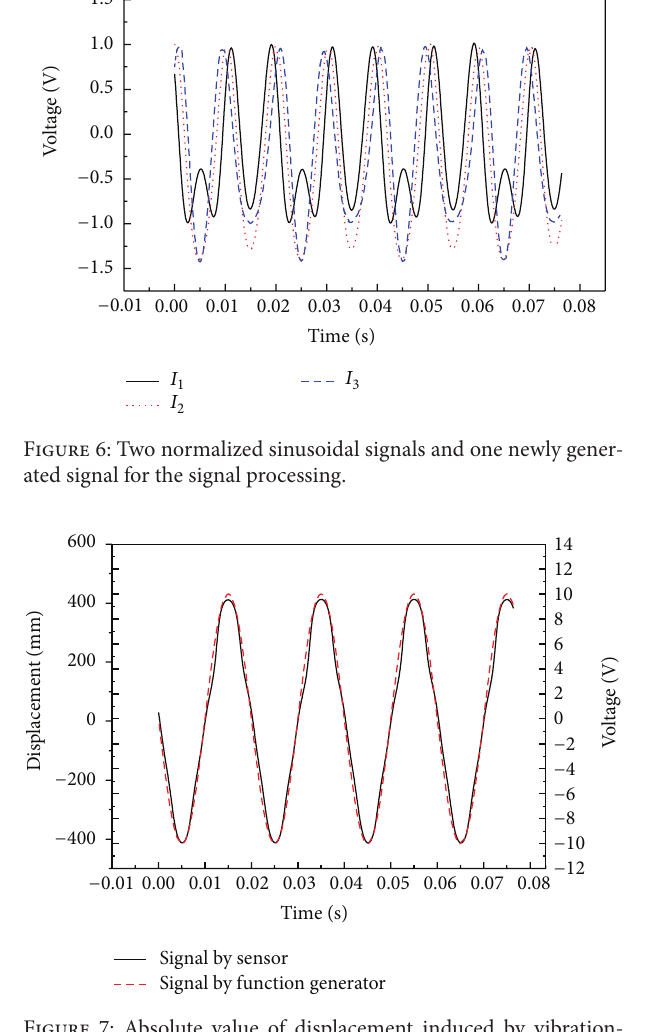
Figure 7: Absolute value of displacement induced by vibration- excitation.